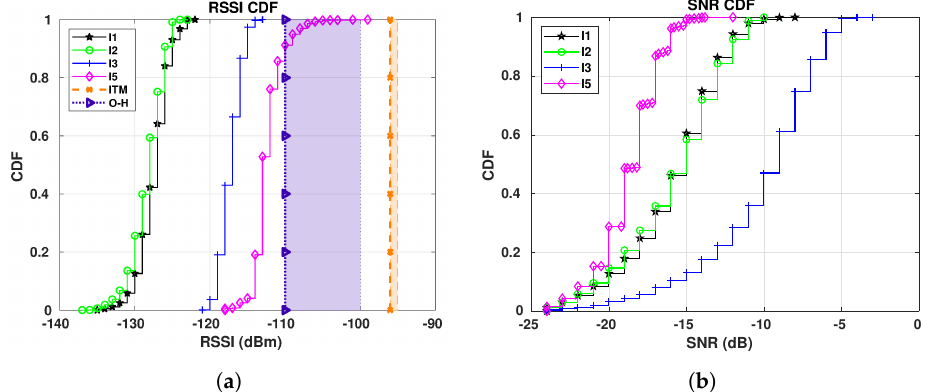
Figure 15. E8 CDFs for GW1 (RSSI and SNR): I1 (16/01/2019 to 07/02/2019): − 16.96 ◦ C on average; I2 (22/12/2018 to 06/01/2019): − 9.45 ◦ C on average; I3 (25/10/2018 to 04/11/20018): − 0.15 ◦ C on average; I5 (15/05/2019 to 22/05/2019): 13.22 ◦ C on average. ( a ) E8 RSSI CDFs for GW1. ( b ) E8 SNR CDFs for